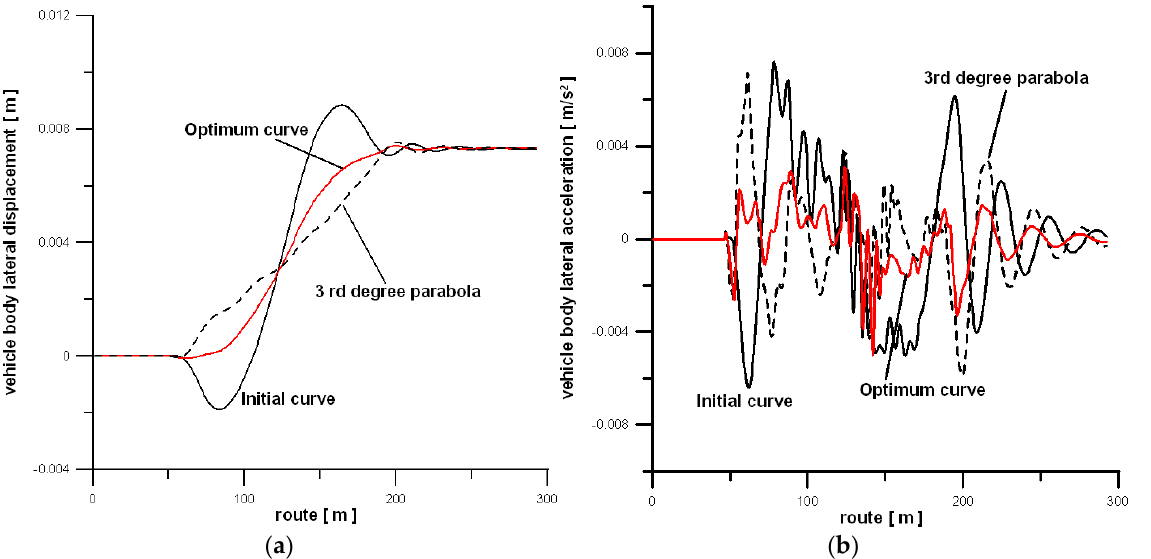
Figure 7. Dynamical characteristics; ( a ) Vehicle body lateral displacements; ( b ) vehicle body lateral accelerations.